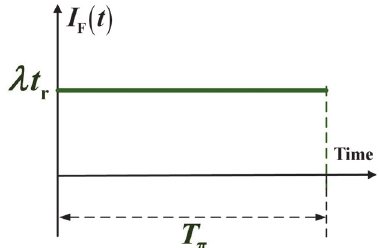
Fig. 7. The safety stock level in condition two of the proposed